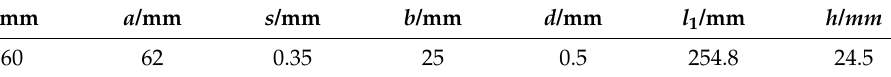
Figure 3. Finite element meshing of the structure. Table 1. Structural parameters.